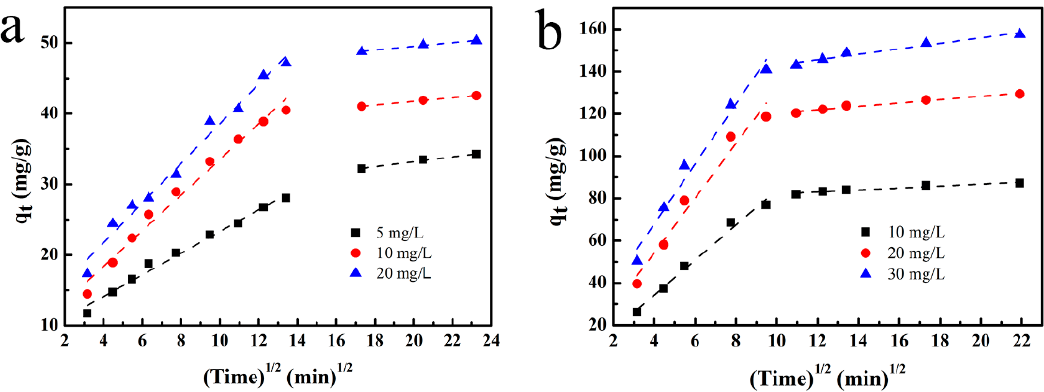
Figure 8. Intra-particle diffusion kinetic model for the adsorption of methylene blue (MB) on UiO-66-NH 2 ( a ) and zeolitic imidazolate framework-8 (ZIF-8)-loaded UiO-66-NH 2 ( b Table 5. Parameters of intra-particle diffusion kinetic model.